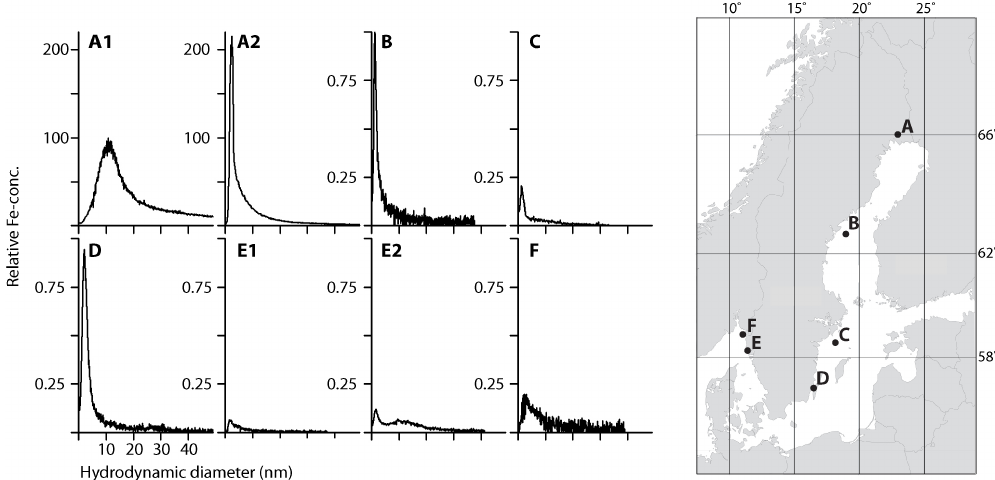
Fig. 1. 0.5–50nm colloidal size spectra of iron is shown to the left (A1–F). The letters correspond to the locations on the map (A–F) where the samples were taken. For station A and E, two different samples are shown in the left figure (A1+A2 and E1+E2 respectively). A. Kalix River at Kamlunge on 9 April 2002 (A1) and during maximum spring flood on 1 May 2002 (A2). B. Bothnian Sea at 5m depth on 19 July 2006. C. Baltic Sea (offshore) at 5m depth on 14 April 2004. D. Baltic Sea at Kalmar Sound (near shore) at 1m depth on 5 September 2005, E. Gullmarsfjord at 10m depth on 21 March 2005 (E1) and on 22 June 2005 (E2). F. Skagerrak Sea (nearshore) at 1m depth on 30 June 2005. Relative Fe-concentrations shown on y-axis are proportional to, but not equal to, concentrations in the